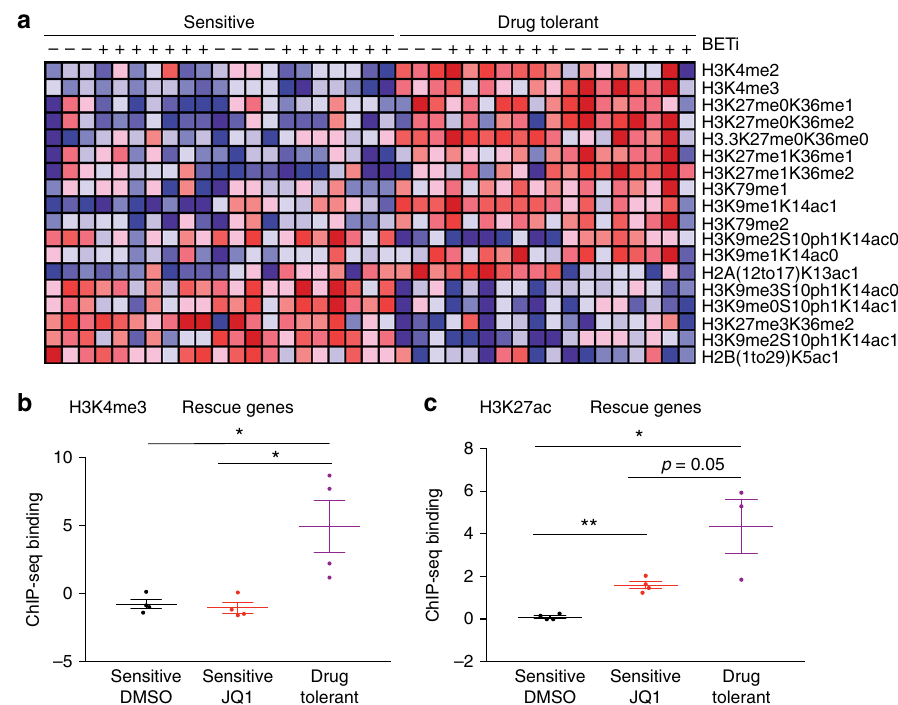
Fig. 6 Drug-tolerant cells exhibit changes in chromatin landscape and activating marks preferentially bind to rescue genes. a Heatmap representing abundances of differentially altered chromatin marks as identi fi ed by global chromatin pro fi ling of sensitive and drug-tolerant D425 and D458 cells passaged in DMSO or BETi (JQ1 and IBET151) for 24 h. Red and blue respectively represent values above and below the median across each row.